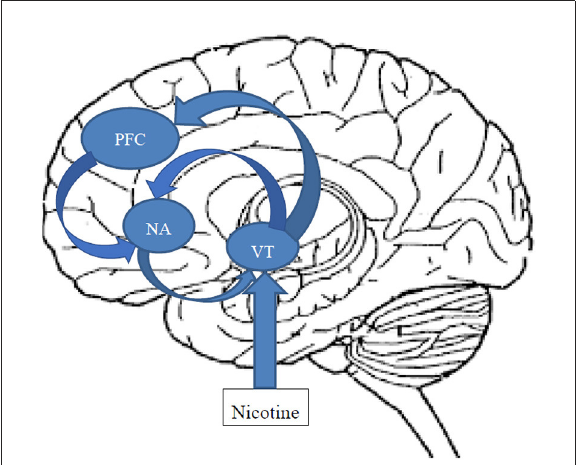
FIGURE1 Schematic and simplified representation of the action of nicotine on the mesocorticolimbic dopaminergic reward circuitry. After passing the brain-blood barrier, Inhaled nicotine stimulates the low affinity α 7 and the high affinity α 4 β 2 nicotinic receptors located in the ventral tegmental area (VTA) activating the reward circuitry. Dopaminergic and glutamatergic neurons project from the VTA to the core and shell of the nucleus accumbens (NAC), as well as to the prefrontal cortex (PFC), glutamatergic neurons from the PFC to the NAC, and GABAergic neurons from the NAC back to the VTA. Both hyperexcitation of the VTA, e.g., by nicotine, as well as lack of inhibition by GABAergic projections from the NAC can result in rapid dopamine release.